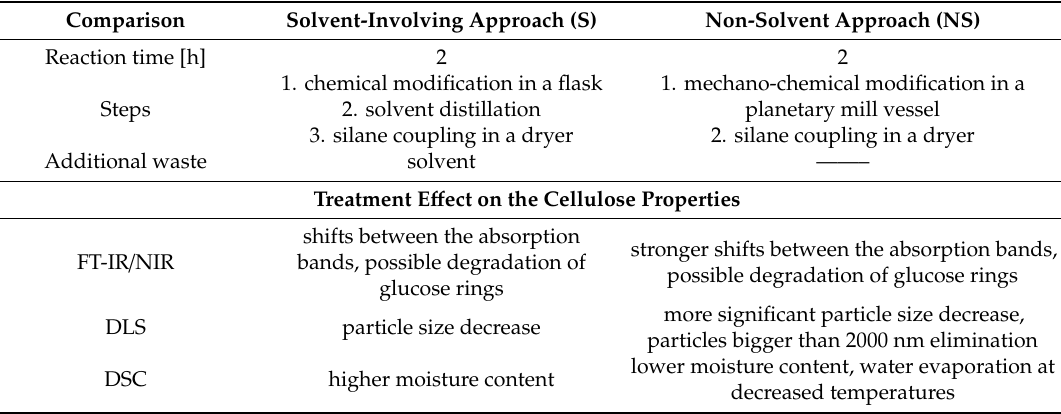
Table 4. Comparison of solvent-involving (S) and non-solvent (NS) modification